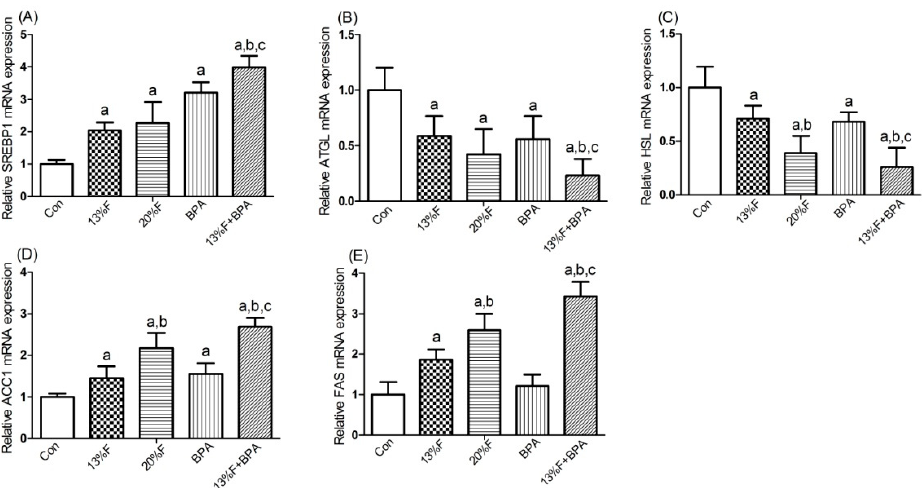
Figure 4. E ff ects of fructose and / or BPA exposure on the expression of genes involved in lipid metabolism in liver. Gene expression (qPCR) of ( A ) SREBP1 ; ( B ) ATGL ; ( C ) HSL ; ( D ) ACC1 ; ( E ) FAS in male rats after eight weeks of treatment with fructose or / and BPA. Values are expressed as means ± SD, n = 6. Di ff erences between groups were considered as significant at p < 0.05 and were analyzed with one-way ANOVA. a di ff erent compared to Con; b di ff erent compared to 13% F; c di ff erent compared to BPA ( p < 0.05). Con, control group; F, fructose group; BPA, 1 µ g / mL BPA